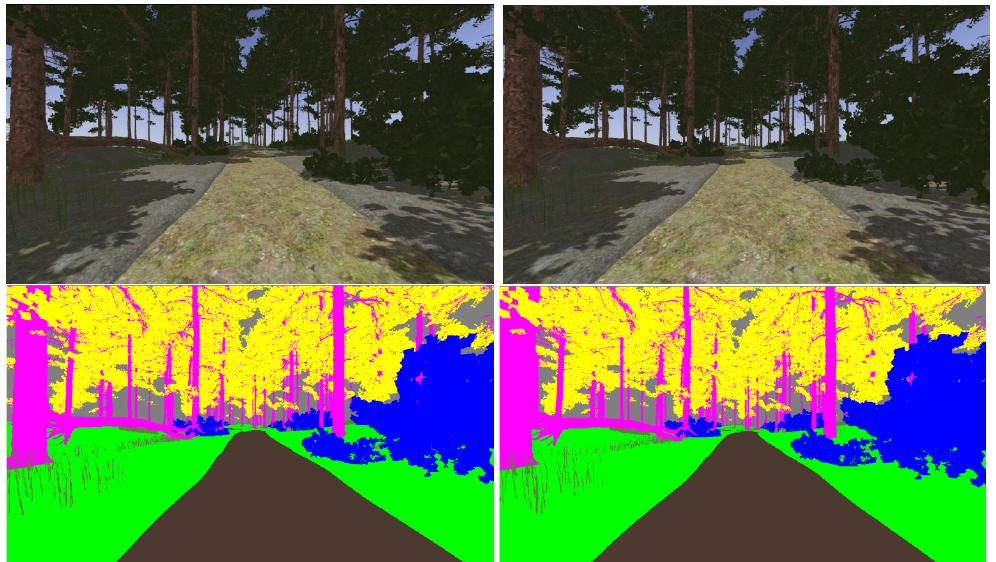
Figure 19. Realistic ( up ) and tagged ( down ) stereo image pairs ( left-right ) taken from the forest